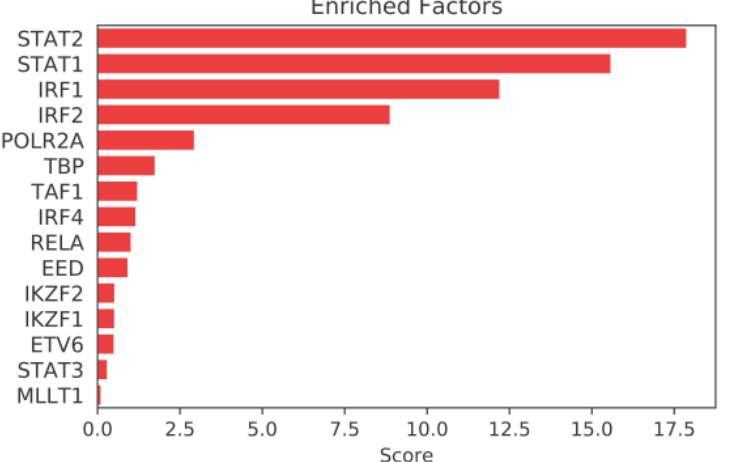
Figure 4. MAGIC analysis on the list of upregulated genes after TCF19 expression in INS-1 cells identifies significant enrichment for genes with known ChIP signals for STAT1, STAT2, and IRF1 in their promoters (FDR < 10%). A higher score reflects increased likelihood that the factor is enriched for binding gene regions in the list of upregulated genes. Genes included in analysis were those that were upregulated more than 2-fold with an associated FDR < 5%.